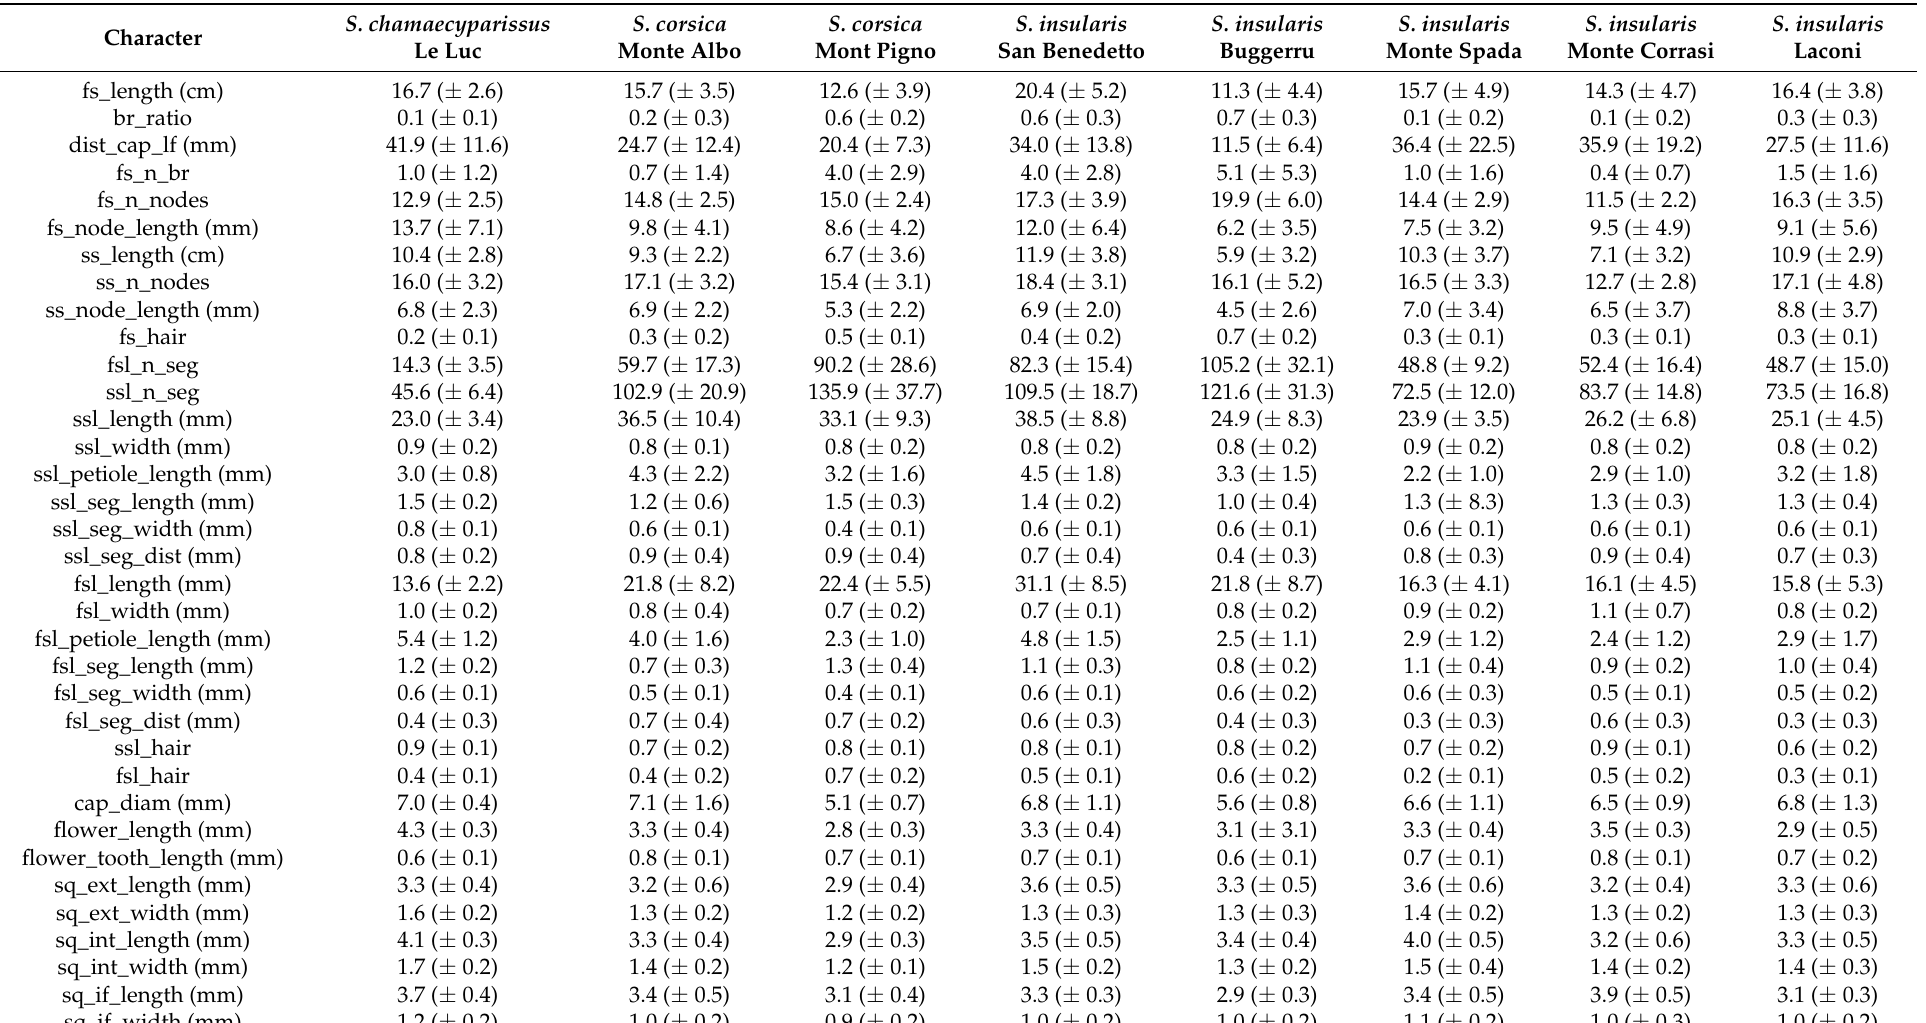
Table 12. Mean ( ± standard deviation) values quantitative morphological characters for each Santolina population. Character codes follow Table